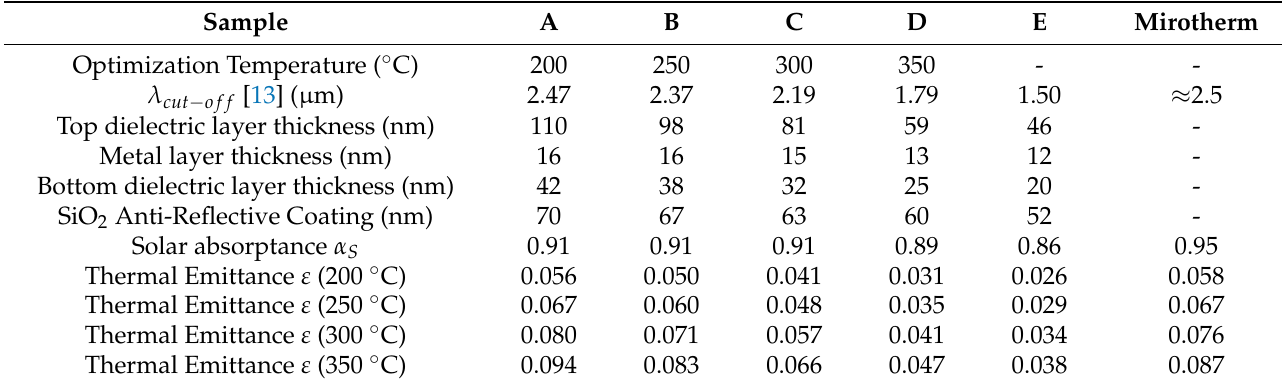
Table 1. Optimization temperature, λ cut − of f for desired operating temperature, layer thickness obtained from the opti- mization process, solar absorptance α S and thermal emittance ε ( T ) at 200 ◦ C, 250 ◦ C, 300 ◦ C and 350 ◦ C calculated from Equations (3) and 4, for 5 multilayer absorbers. Sample E was designed to have a λ cut − of f = 1.50 µ m. In the last column the absorptance and emittance values of Mirotherm are reported [28].